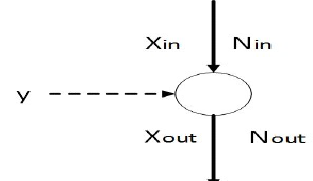
Figure 11. Schematic representation of the information node [12]